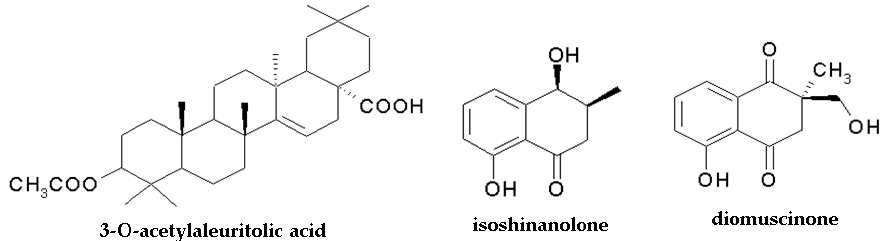
Figure 4. Chemical structure of components with anticancer activity found in Nepenthales. The structure of plumbagin, 3-chloroplumbagin, and ramentaceone is shown in Figure 2.